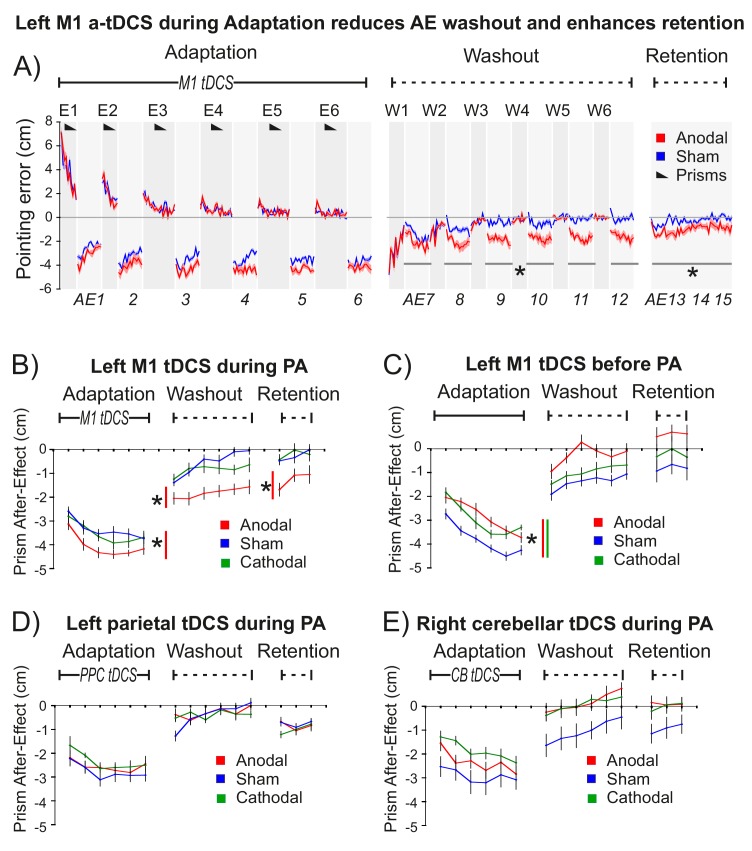
M1 a-tDCS during Prism Adaptation (PA) enhanced consolidation of the prism after-effect.The x-axis represents baseline accuracy (zero error), with prism after-effect (AE) data representing changes from baseline. For each panel N = 9. Asterisk indicates significant difference between Anodal and Sham (p<0.05). (A) Pointing accuracy in healthy volunteers when anodal (red) or sham (blue) tDCS was applied to M1 during Adaptation (Experiment 1). Black wedges indicate blocks throughout which prisms were worn. During Adaptation (prism exposure, (E1–E6) and Washout (prisms removed, (W1–W6), participants saw the outcome of the trial, so could correct their errors. The AE was measured without visual feedback (AE1-15, shaded light grey). Solid lines show pointing accuracy averaged across participants (shading =±1 SEM). Adaptation and Washout lasted 20 min each. Retention lasted 6 min after 10 min of blindfolded rest. Relative to sham, anodal tDCS increased AE persistence throughout Washout and Retention: note the leftward shift in AE7-15 (no visual feedback), whereas accuracy in interleaved blocks W1-6 is indistinguishable. (B–E) Prism after-effect in different stimulation conditions. Panel (B) summarizes group mean AEs (±1 SEM) for the dataset shown in (A) (AE1-15 only) and also shows data for reversed polarity stimulation (cathodal, green). Other panels plot the same summary AE data for stimulation of: (C) M1 before Adaptation (Experiment 2); (D) right posterior parietal cortex (PPC) during Adaptation (Experiment 3); E) right cerebellum (CB) during Adaptation (Experiment 4).